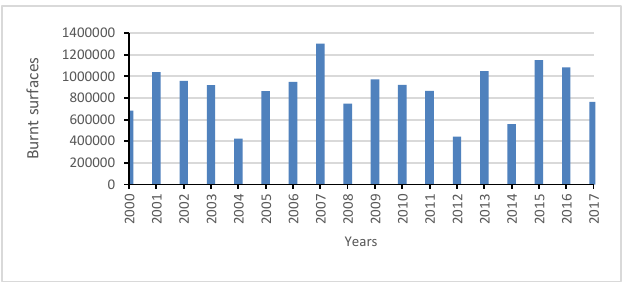
Figure 9: Annual evolution of burnt surfaces from 2000 to 2017